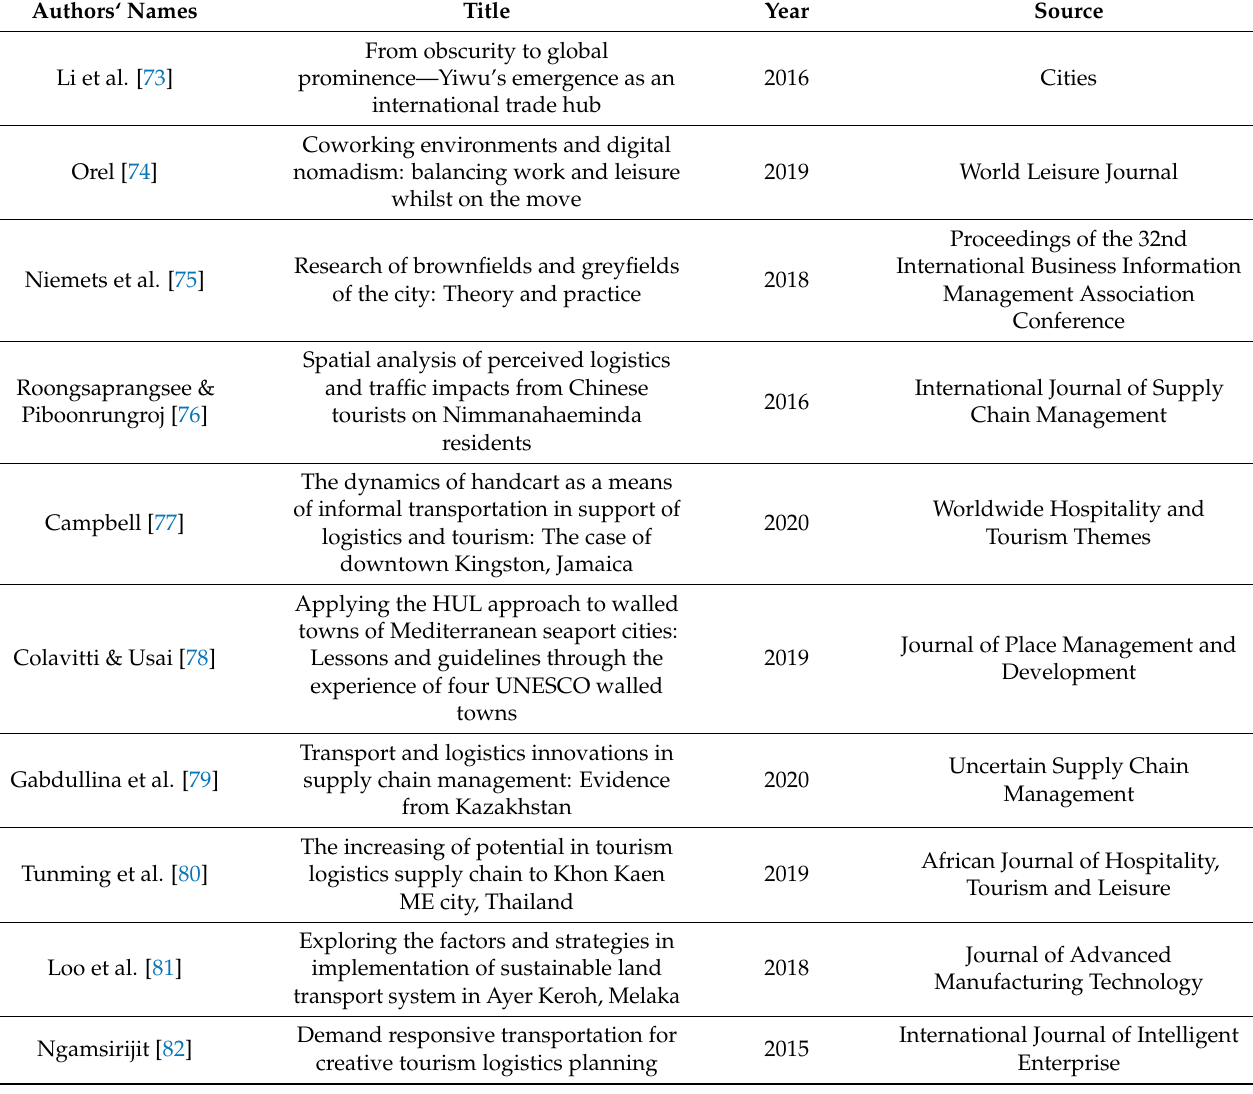
Table 2. The most frequently cited papers related to city logistics in the urban tourist area, in the subject area of business, management, and accounting, in 2011–2022. Source: Own elaboration based on data from the Scopus